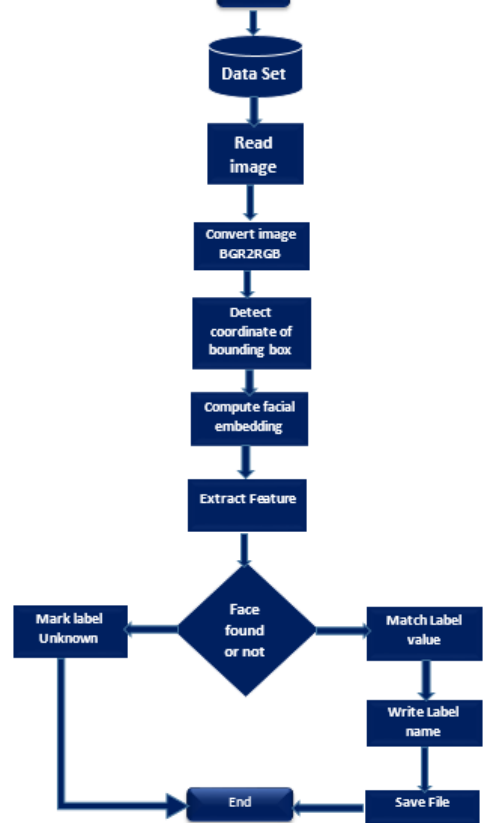
Figure 5. Flow chart of proposed